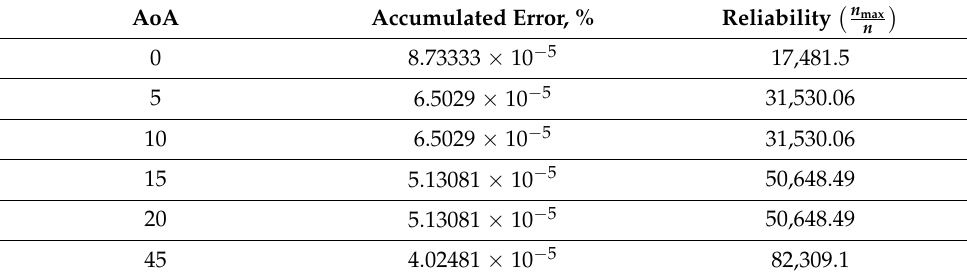
Table 2. Accumulated error and reliability estimation for calculated